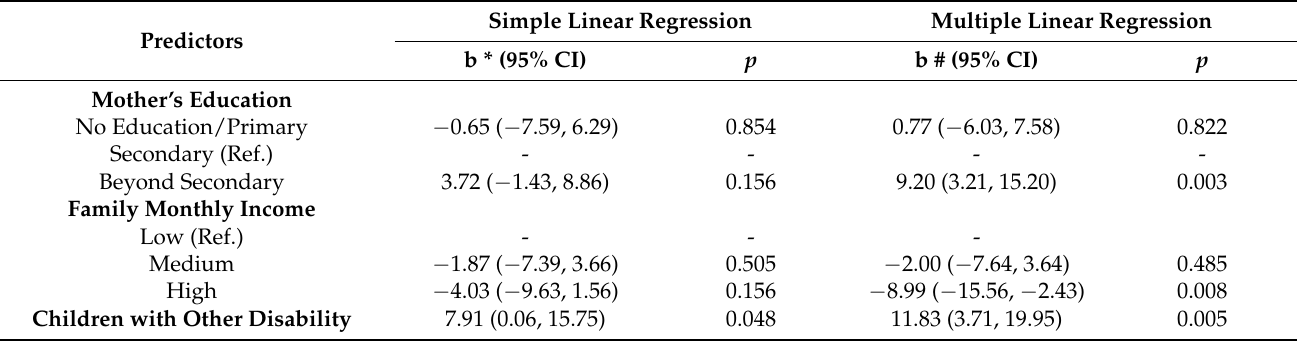
Table 6. Factors Associated with Family Functioning ( n =